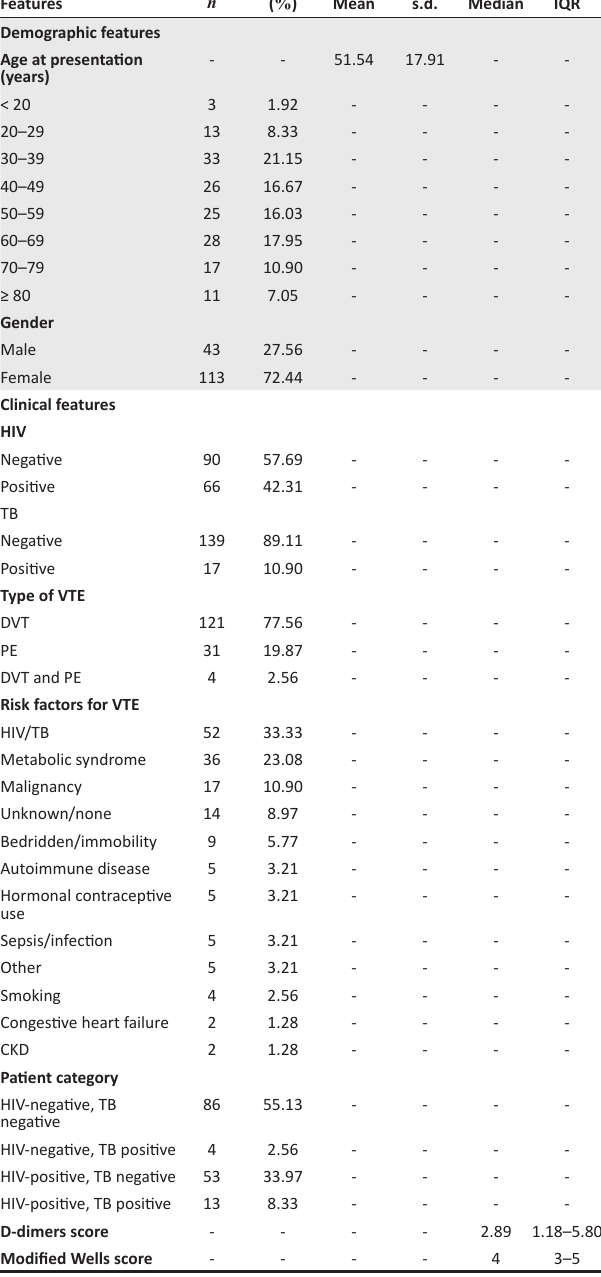
TABLE 1 : Summary of the characteristics, D-dimer scores and modified Wells scores of patients included in this study with venous thromboembolism ( n = 156).